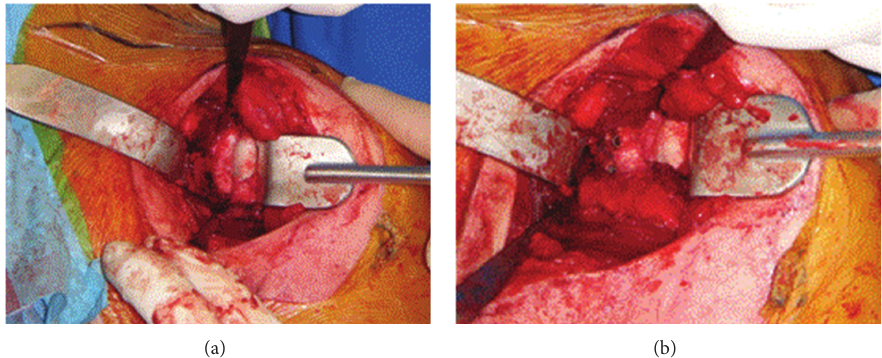
Figure 8: Intraoperative photographs demonstrating the Latarjet procedure through subscapularis split.